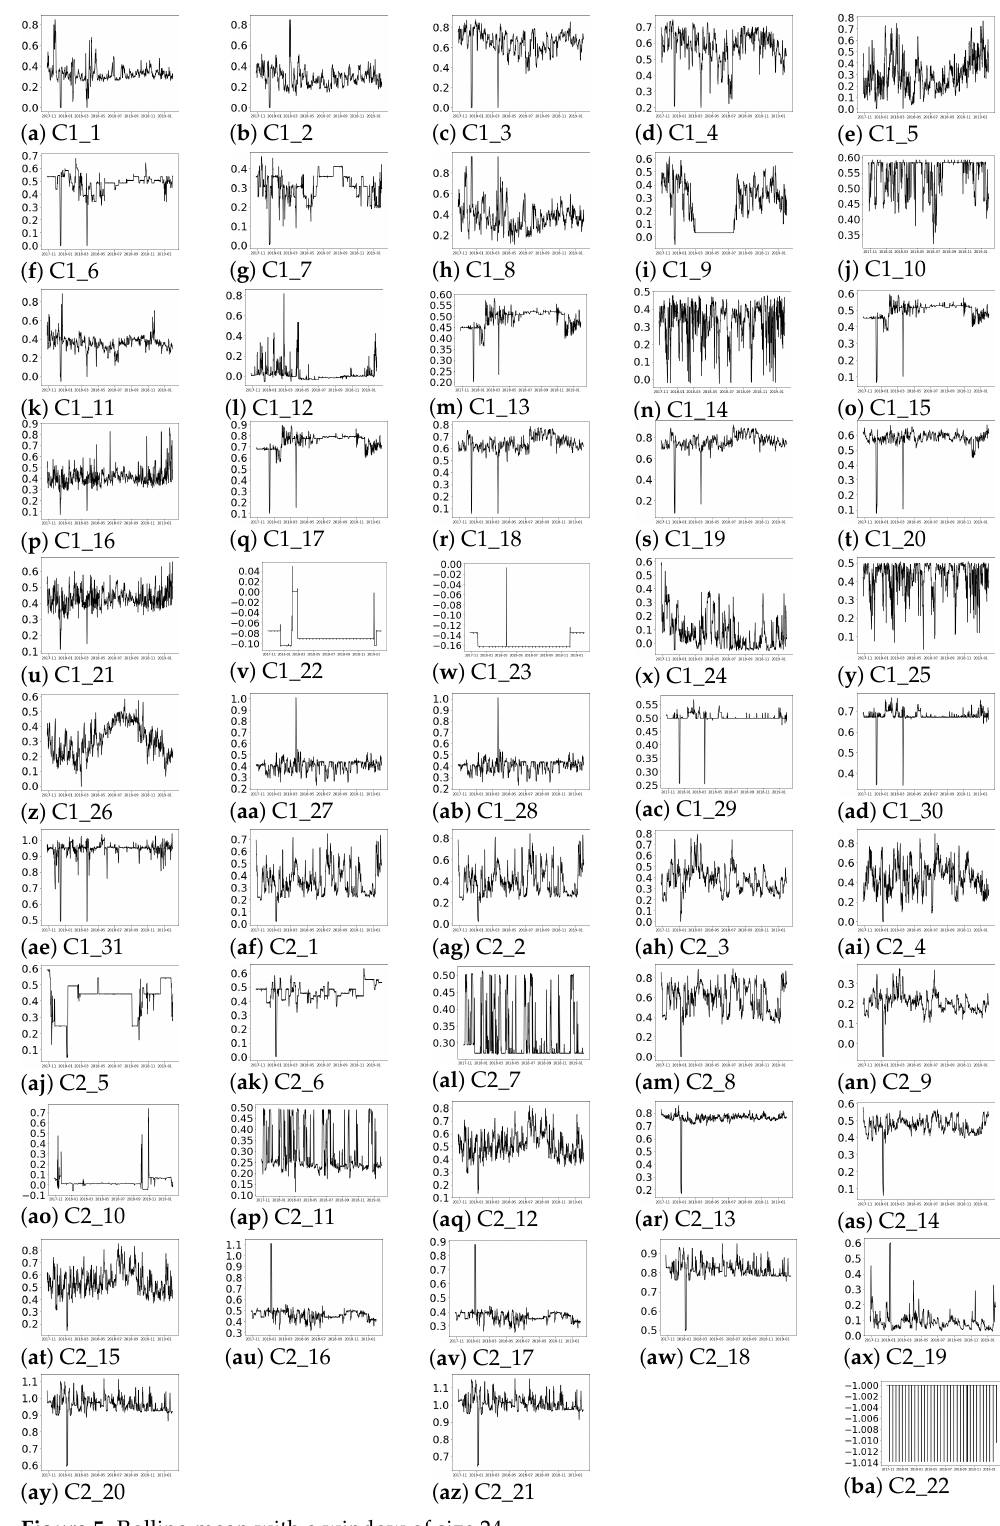
Figure 5. Rolling mean with a window of size